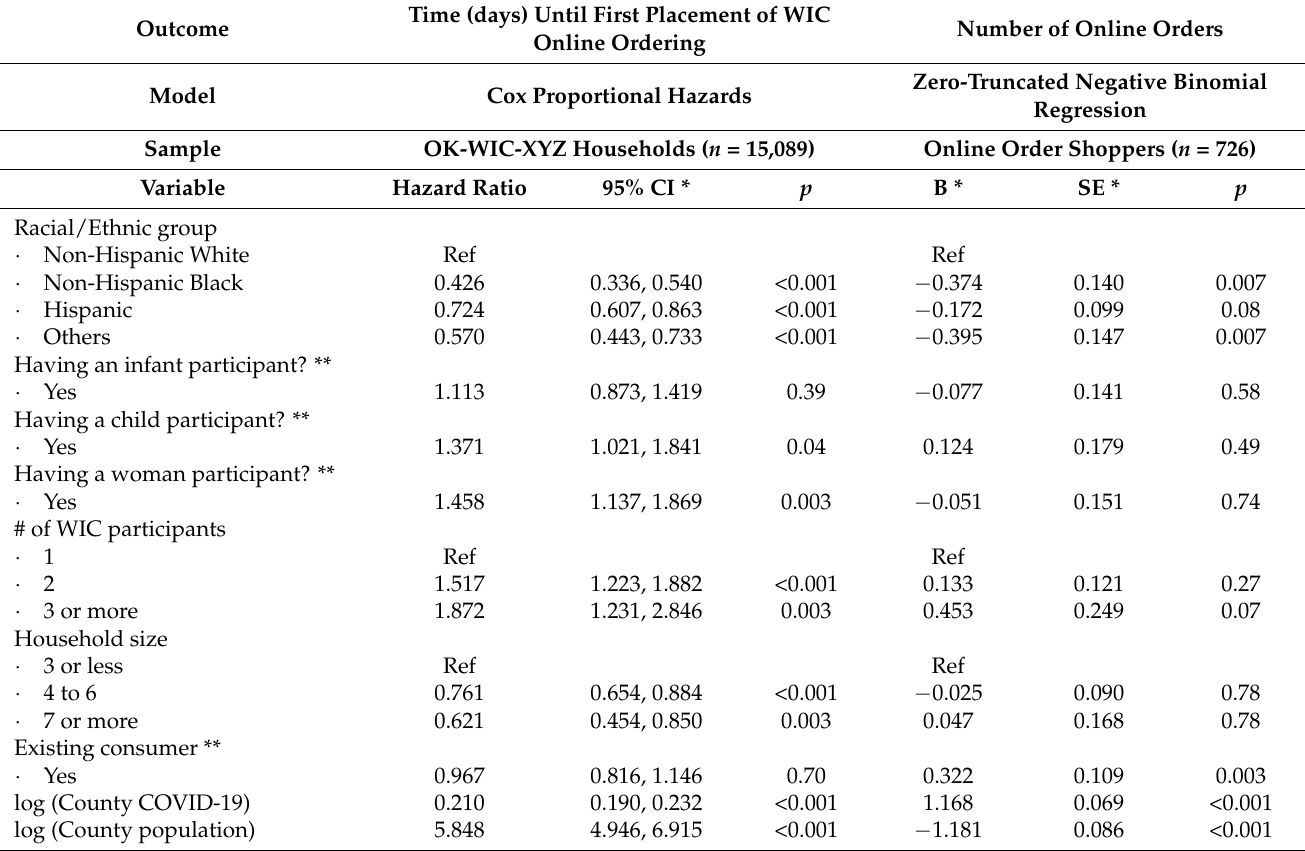
Table 3. Regression results of time to place the first online order and number of online